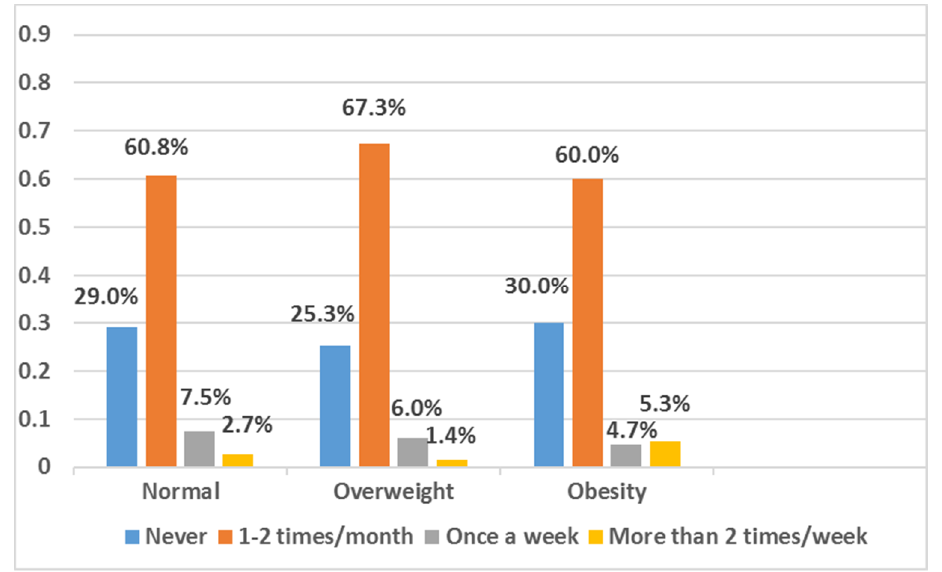
Figure 2. Frequency of eating fast food (KFC, McDonalds, etc.) among school-age children by BMI categories.